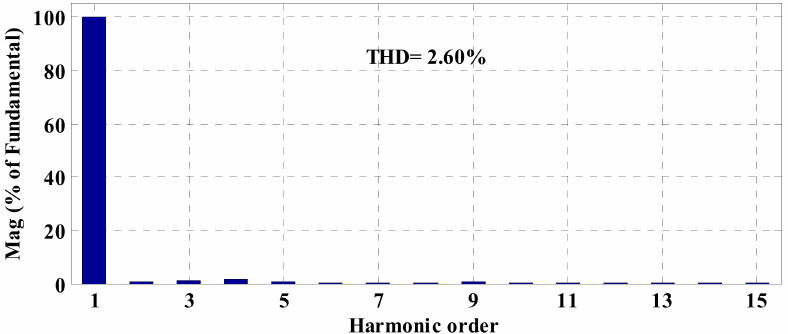
Figure 12. THD spectra of the injected current of DG1 based on the conventional control method.